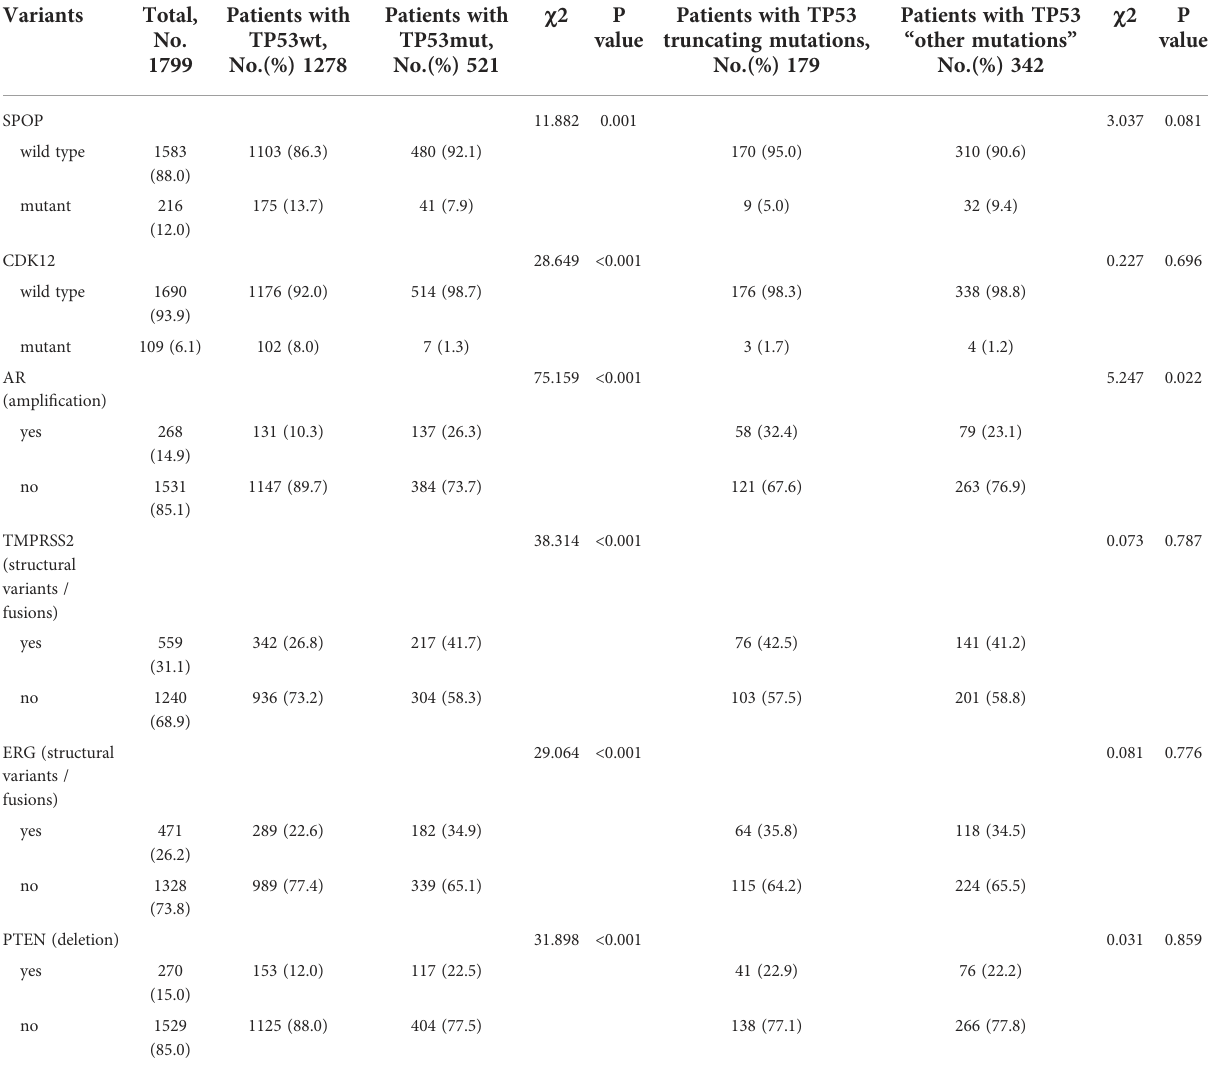
TABLE 1 Signi fi cant genomic alterations between TP53wt and TP53mut tumors. Variants Total,